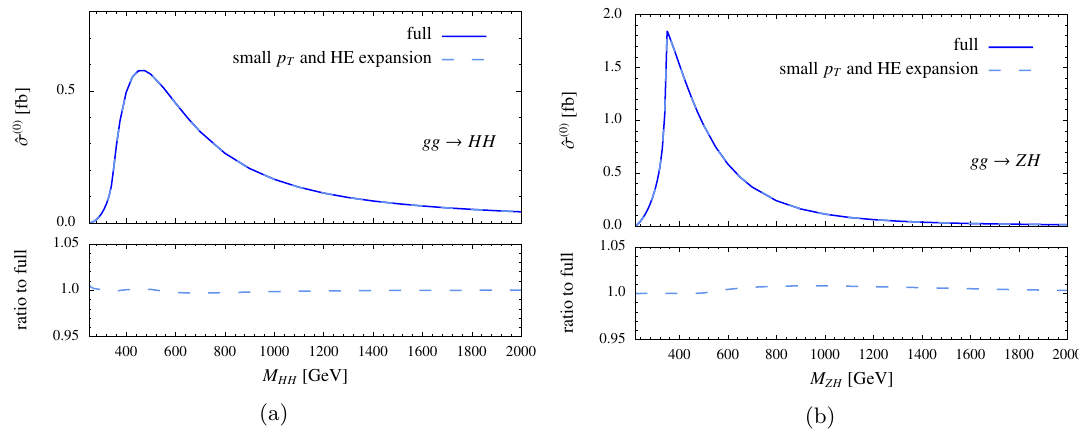
Figure 2. Partonic cross section at LO for (a) gg → HH and (b) gg → ZH . The upper part of each plot shows the exact prediction (solid line) together with the merging of the p approximants (dashed line). The bottom part of each plot shows the ratio of the merged result to the exact